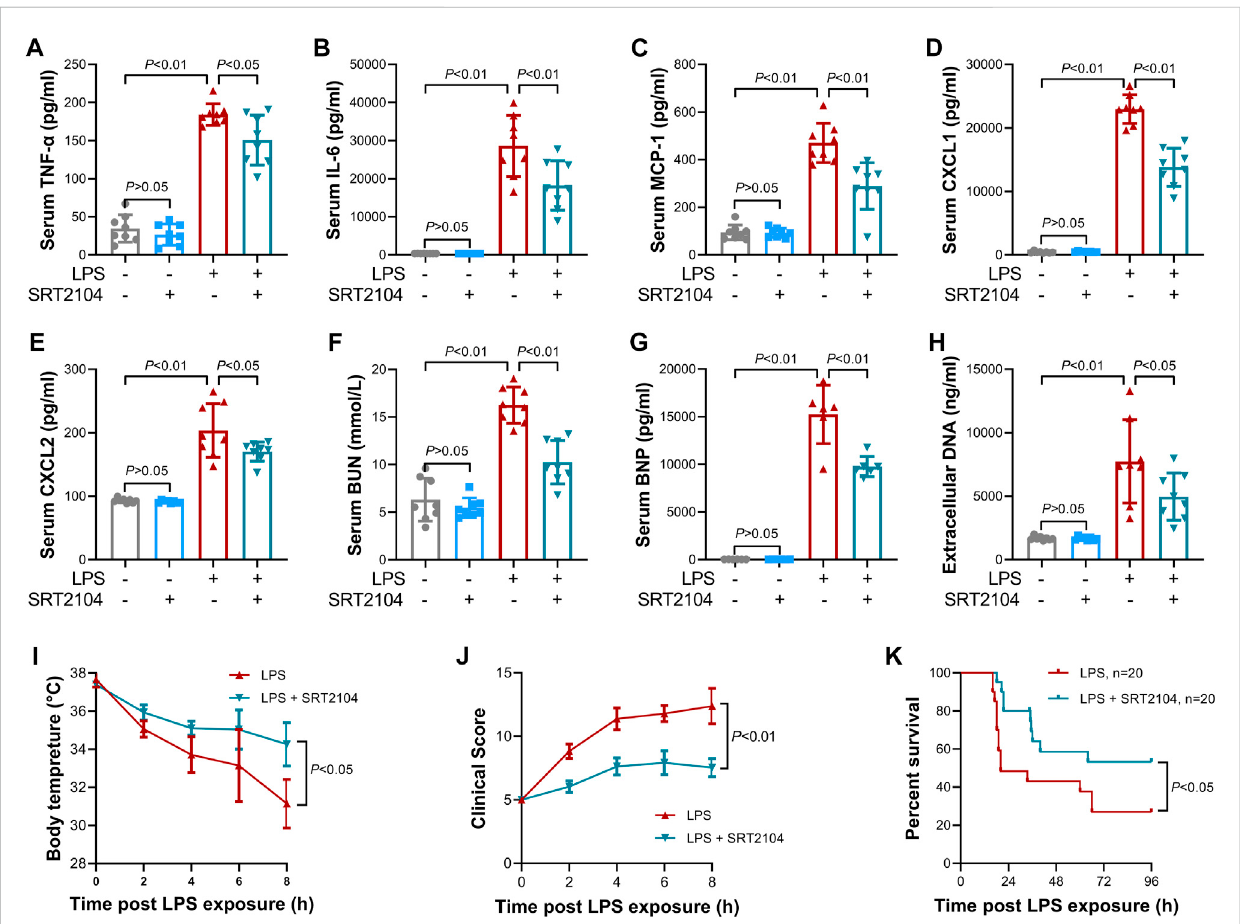
FIGURE 3 SRT2104 alleviated LPS-induced systemic in fl ammation. C57BL/6 mice were challenged with LPS to induce systemic in fl ammation, vehicle or SRT2104 (25 mg/kg) was administered intraperitoneally. The mice were sacri fi ced 8 h post LPS exposure, and the serum samples were collected. (A – E) The serum levels of (A) TNF- α , (B) IL-6, (C) MCP-1, (D) CXCL1 and (E) CXCL2 were determined; (F,G) The serum levels of (F) BUN and (G) BNP were determined; (H) The level of extracellular DNA in serum was determined; (I) The body temperature of the experimental animals was recorded; (J) The clinical score of the experimental animals was calculated; n = 8; (K) The survival of the experimental animals was monitored, n = 20. Data were expressed as means